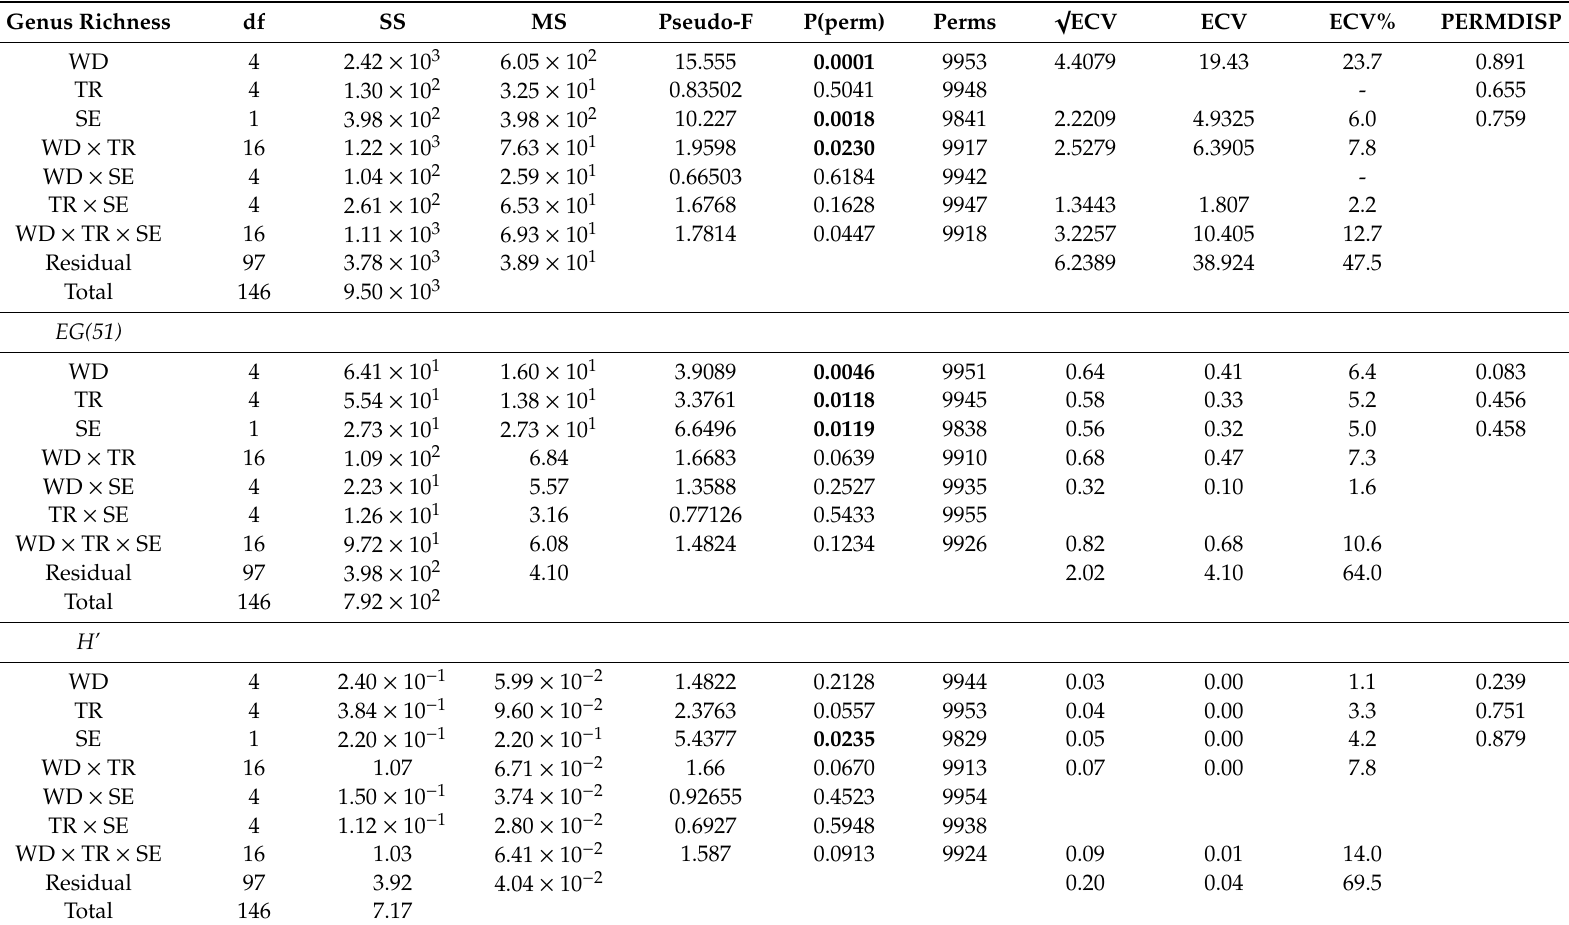
Table 3. PERMANOVA (Permutational multivariate analysis of variance) results for structural diversity indices, functional measures, and community structure using the three-way fixed model (water depth—WD, transect—TR, season—SE). Df: degrees of freedom; SS: sums of squares; MS: means of squares; P(perm): p -value based on permutational analysis; Perms: number of permutations; ECV: estimated component of variation (ECV% represents the ECV value relative to the total variation); PERMDISP: P(perm) results for homogeneity of multivariate